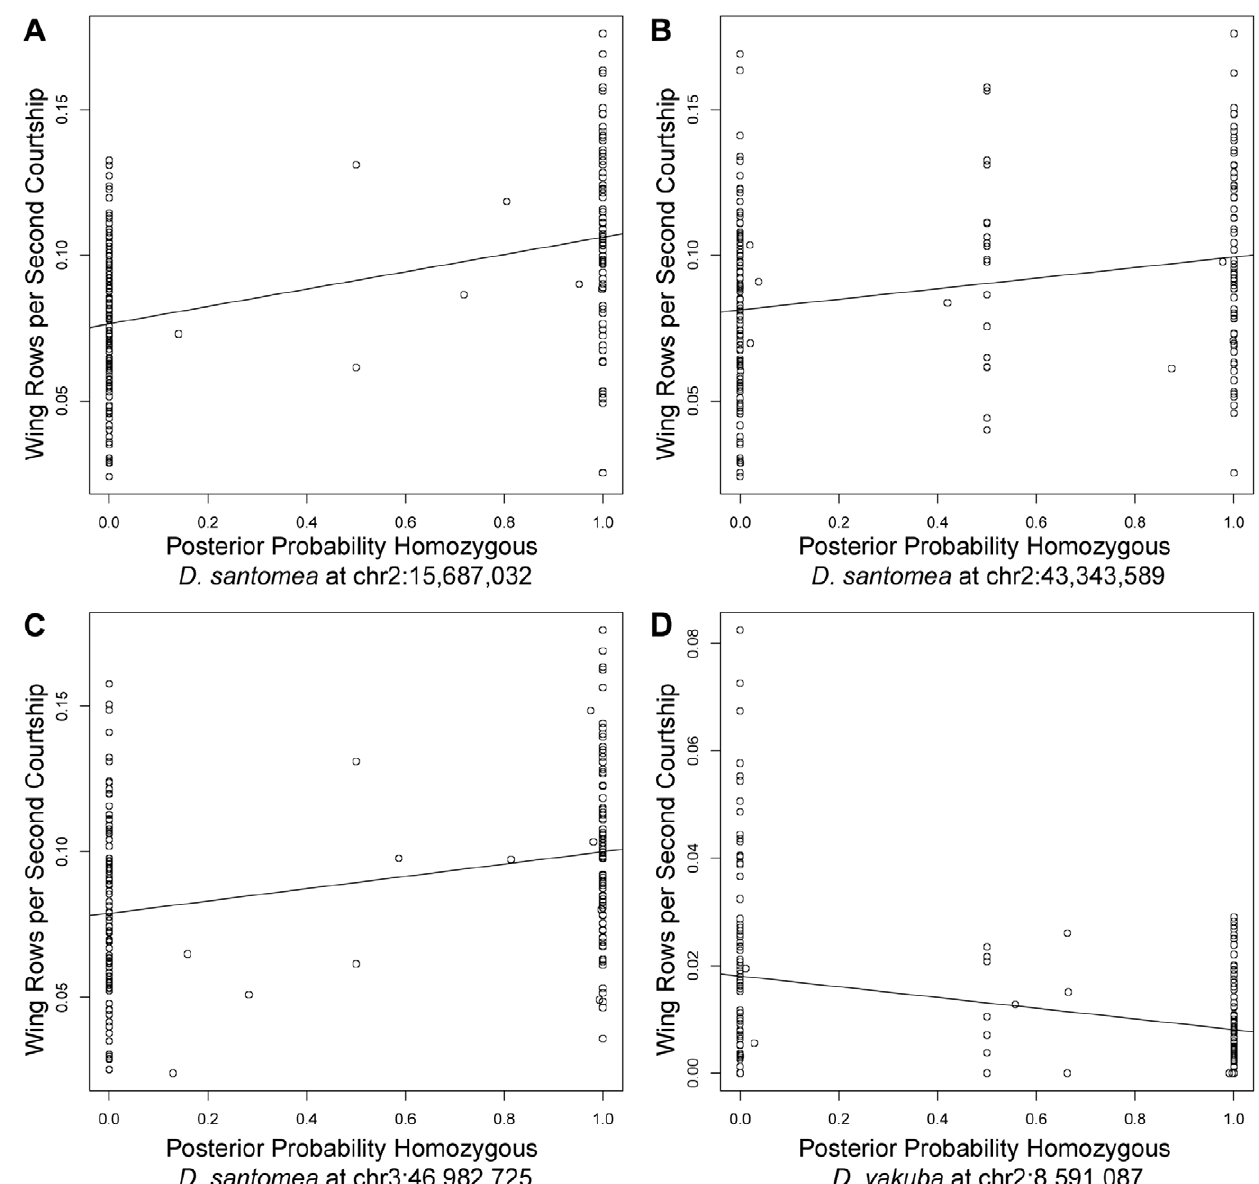
Figure 4. Effect plots for wing rowing QTL. (A) Effect plot for the QTL on chromosome 2 at 15,687,032 bp for the D. santomea backcross. (B) Effect plot for the QTL on chromosome 2 at 43,343,589 bp for the D. santomea backcross. (C) Effect plot for the QTL on chromosome 3 at 46,982,725 bp for the D. santomea backcross. (D) Effect plot for the QTL on chromosome 2 at 8,591,087 bp for the D. yakuba backcross. For each plot, the posterior probability of homozygosity as predicted by the HMM for backcross hybrid flies at the marker for the peak LOD score for each QTL is plotted on the x-axis. Heterozygous flies have a value of 0, homozygous flies a value of 1, and flies where the genotype is uncertain due to low marker density fall between zero and one. The number of wing rows normalized to seconds spent courting is plotted on the y axis.